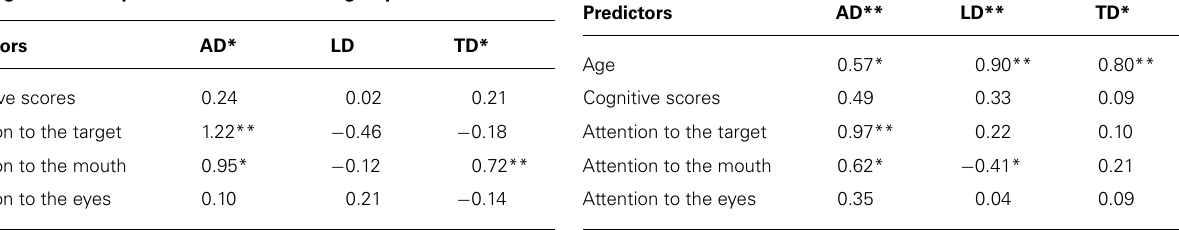
Table 2 | Linear regression beta weights and significance for Preschool Language Scale composite raw scores within groups.